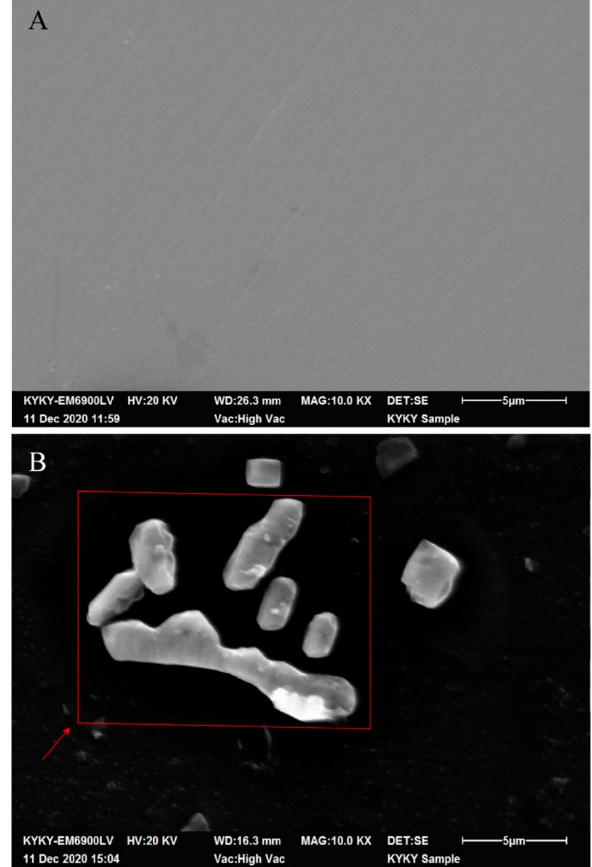
Figure 4. Scanning electron microscopy of the electrode surface after electrochemical detection. ( A ) The surface of the GCE after testing the sterile electrolyte was smooth and tidy; ( B ) after detecting the bacteria-containing electrolyte, the GCE surface had obviously adsorbed the bacterial cell struc- ture.